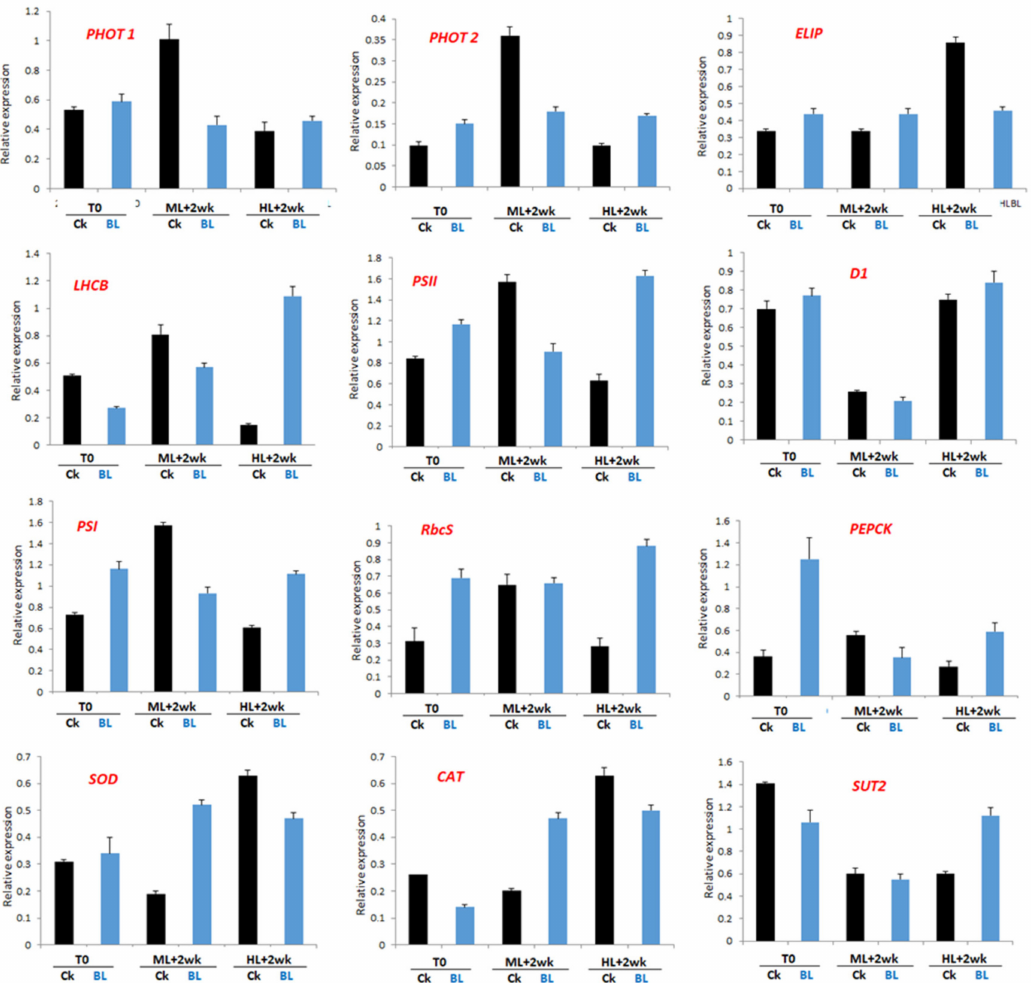
Figure 9. Quantitative RT-PCR showed that blue light treatment altered the gene expression patterns of mature orchid plants. RNA samples were collected from 2.5” potted plants at two weeks after exposure to moderate light at 500 µ mol m 2 s − 1 (ML) or high light at 1000 µ mol m 2 s − 1 (HL). Error bars indicate the SD of the mean from three